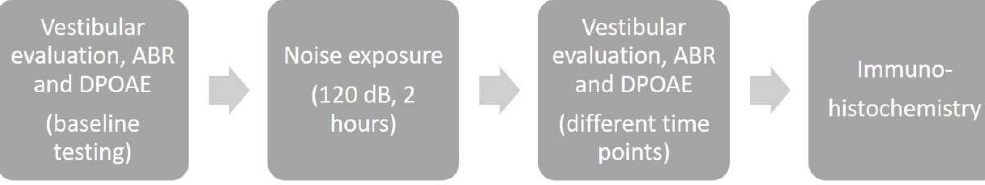
Figure 11. Schematic study design.